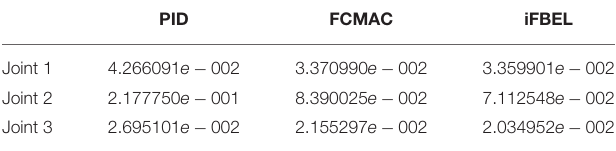
TABLE 3 | The accumulated RMSE values of each joint at ρ 1 = 2.0.